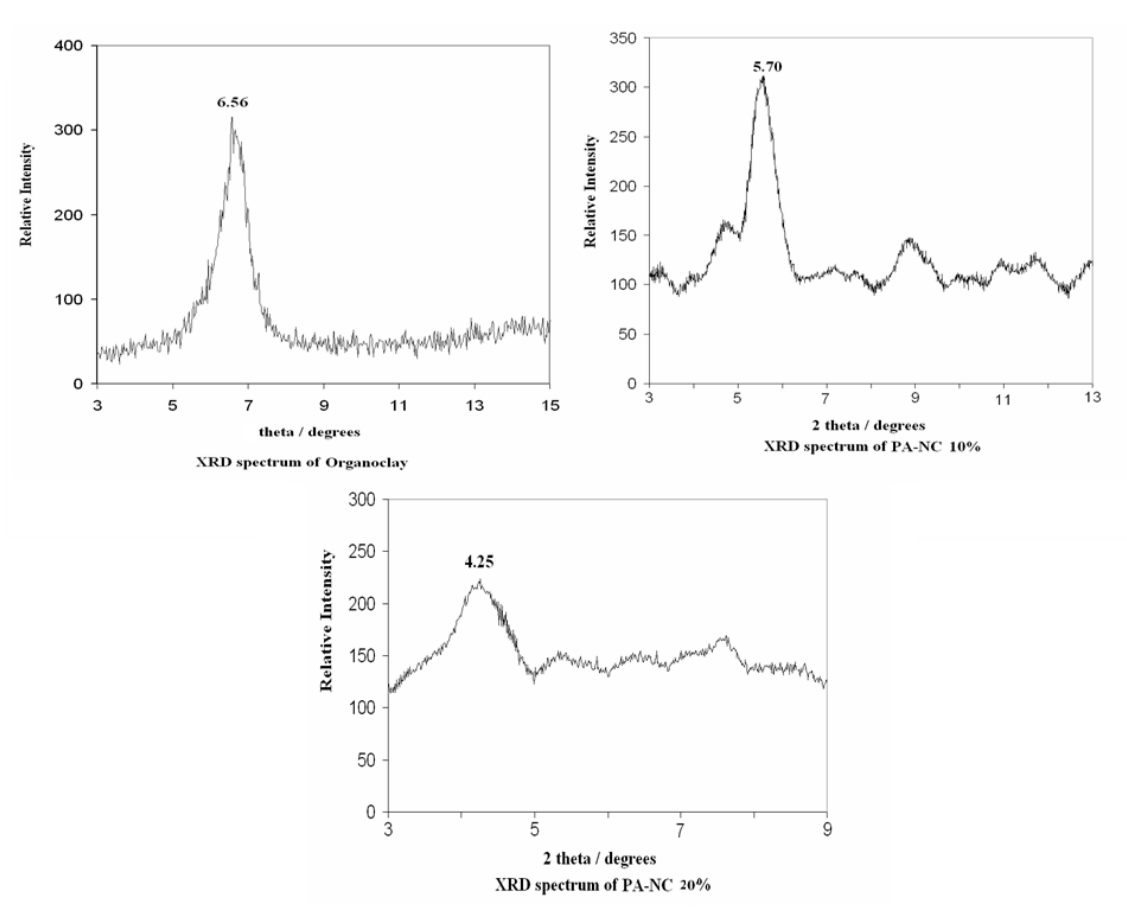
Figure 5. X-ray diffraction patterns of Organoclay (a), PAI-nanocomposite films 4a (b) and 4b